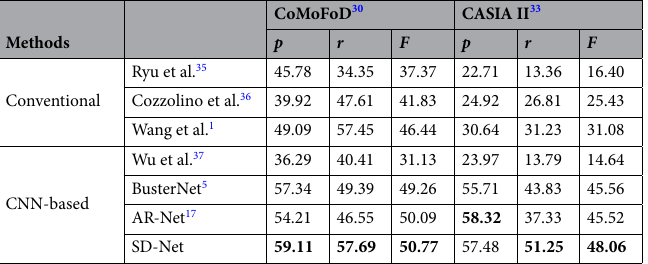
Table 2. Detection results compison in terms of average p , r , and F (%) between the SD-Net and other methods on CoMoFoD 30 and CASIA II 33 datasets. Maximum values are in bold.